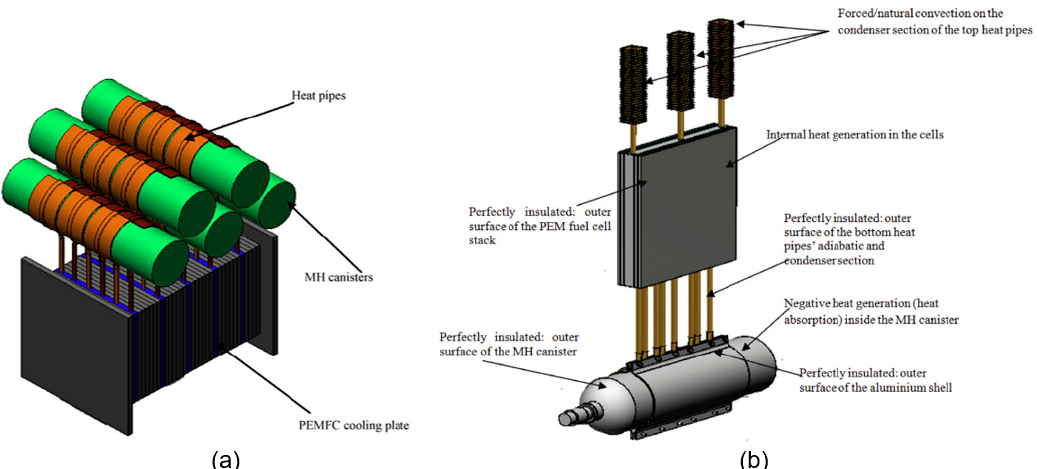
Figure 8. Thermally coupled fuel cell and MH tank using ( a ) heat pipes (Reproduced with permission from Ref. [28]. 2022, Elsevier) and ( b ) heat pipes and fins (Reproduced with permission from Ref. [29]. 2022,